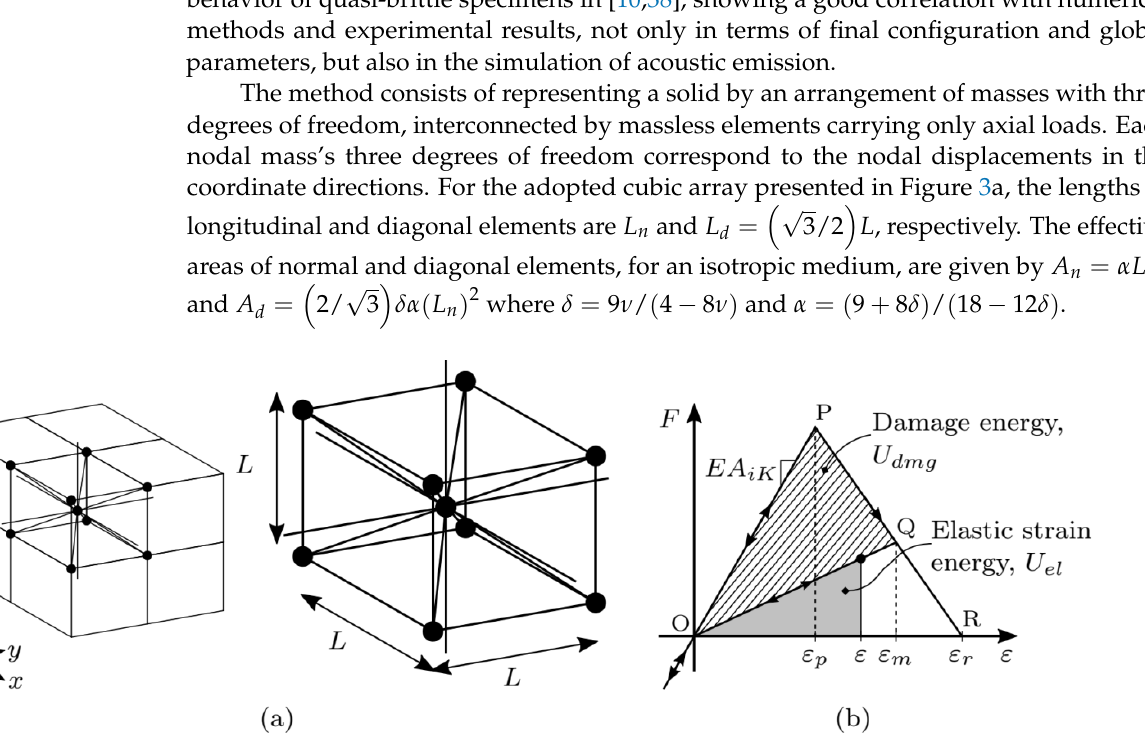
Figure 3. LDEM: ( a ) Basic cubic module employed in the discretization and ( b ) bilinear constitutive law attributed to the elements.